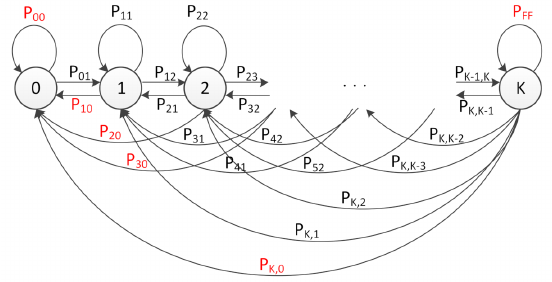
Figure 4. Markov model state transitions for the studied